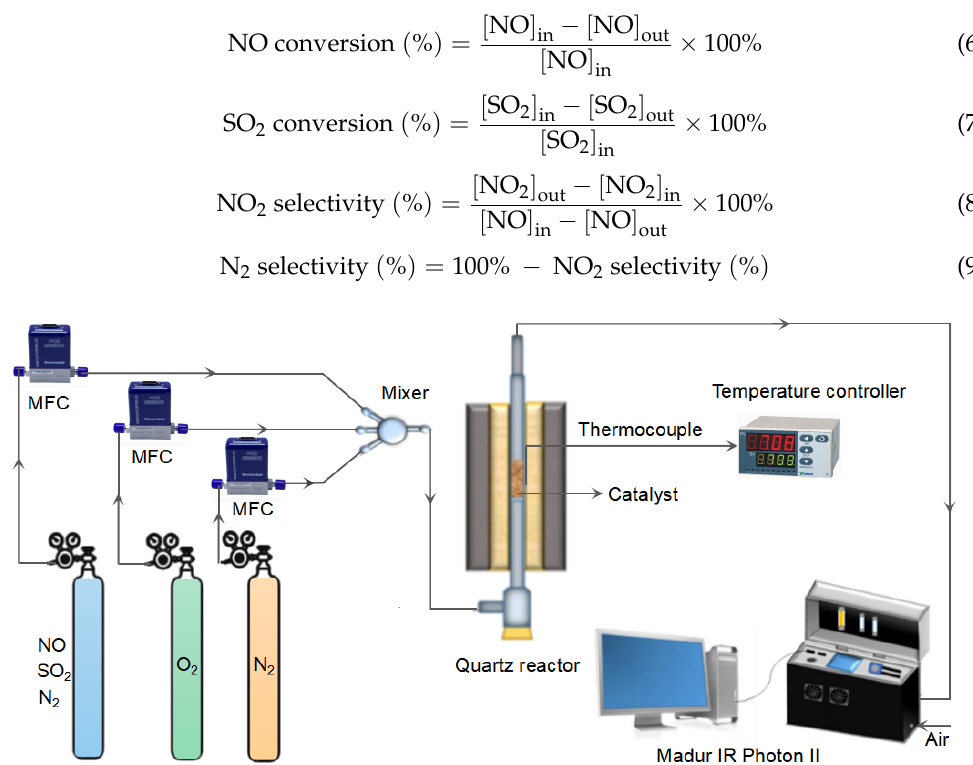
Figure 11. Schematic of the experimental setup for NO decomposition catalytic test.